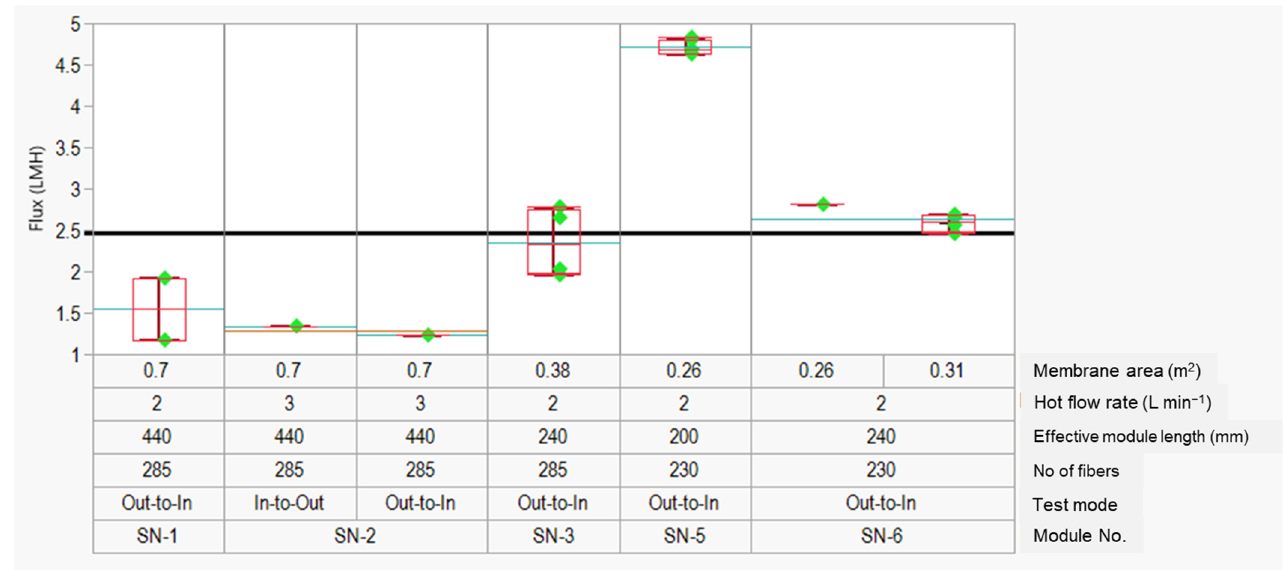
Figure 7. Flux optimization data for the PVDF TBHF membranes under DCMD mode with different module parameters and test conditions. The red boxes indicate the data range for the specific test conditions, whereas the blue lines indicate the group averages for the specific test conditions. The solid black line at 2.5 L m − 2 h − 1 indicates the population mean.